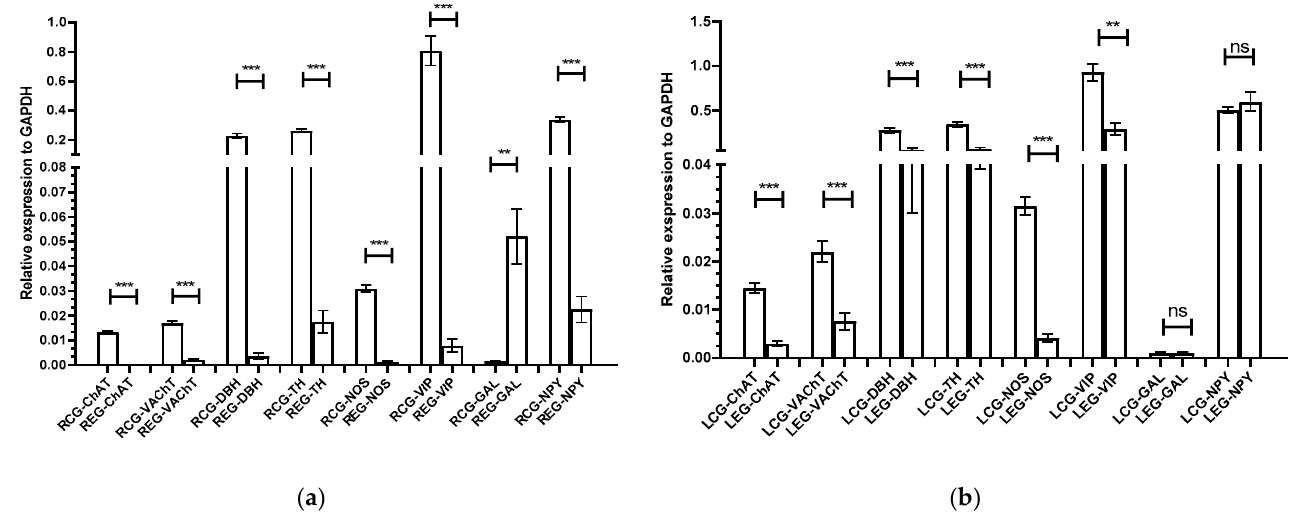
Figure 13. a , b . Analysis of the relative gene expression for ChAT, VAChT, DBH, TH, NOS, VIP, GAL and NPY in the right (R) ( a ) and left (L) ( b ) APG of the control (CG) and experimental (EG) group of animals, normalized against the GAPDH reference gene. *** p < 0.001, ** p < 0.01, ns—no statistically significant differences ( p > 0.05).